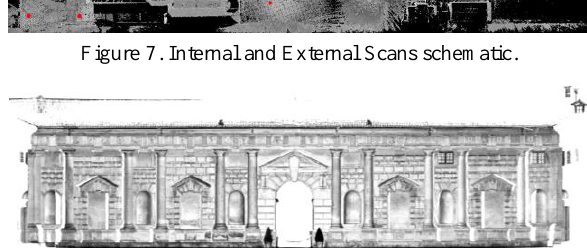
Figure 8. Courtyard of Onor internal north frontage view from Pointools.